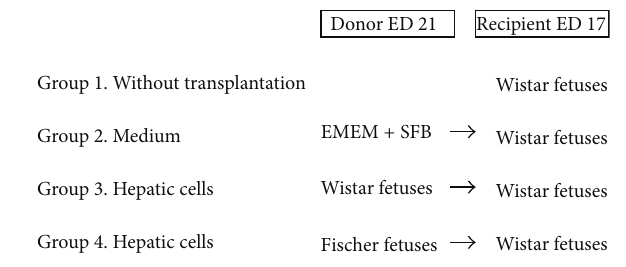
Figure 1: Scheme of the four experimental groups (group 1: 𝑛 = 60 , group 2: 𝑛 = 113 , group 3: 𝑛 = 153 , and group 4: 𝑛 = 163